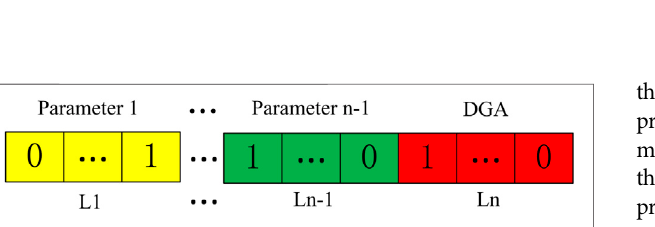
FIGURE1| Thestructuresofthe TGAand the IGA, (A) isTGA ’ sstructure, (B) isIGA ’ sstructure.The IGAdiffersfrom GAwith twomodi fi cations: thehigh mutation rate of 0.3, and the other is the addition of elitist selection in the population selection process.